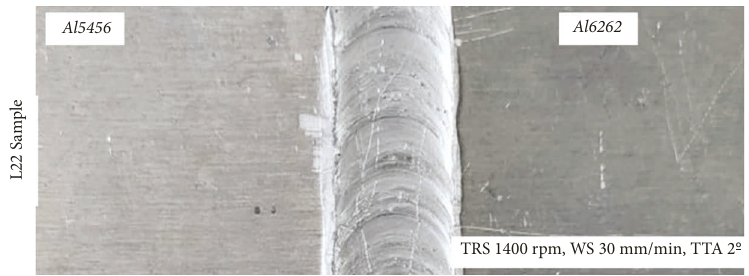
Figure 10: Maximum tensile strength attained at L22 sample.